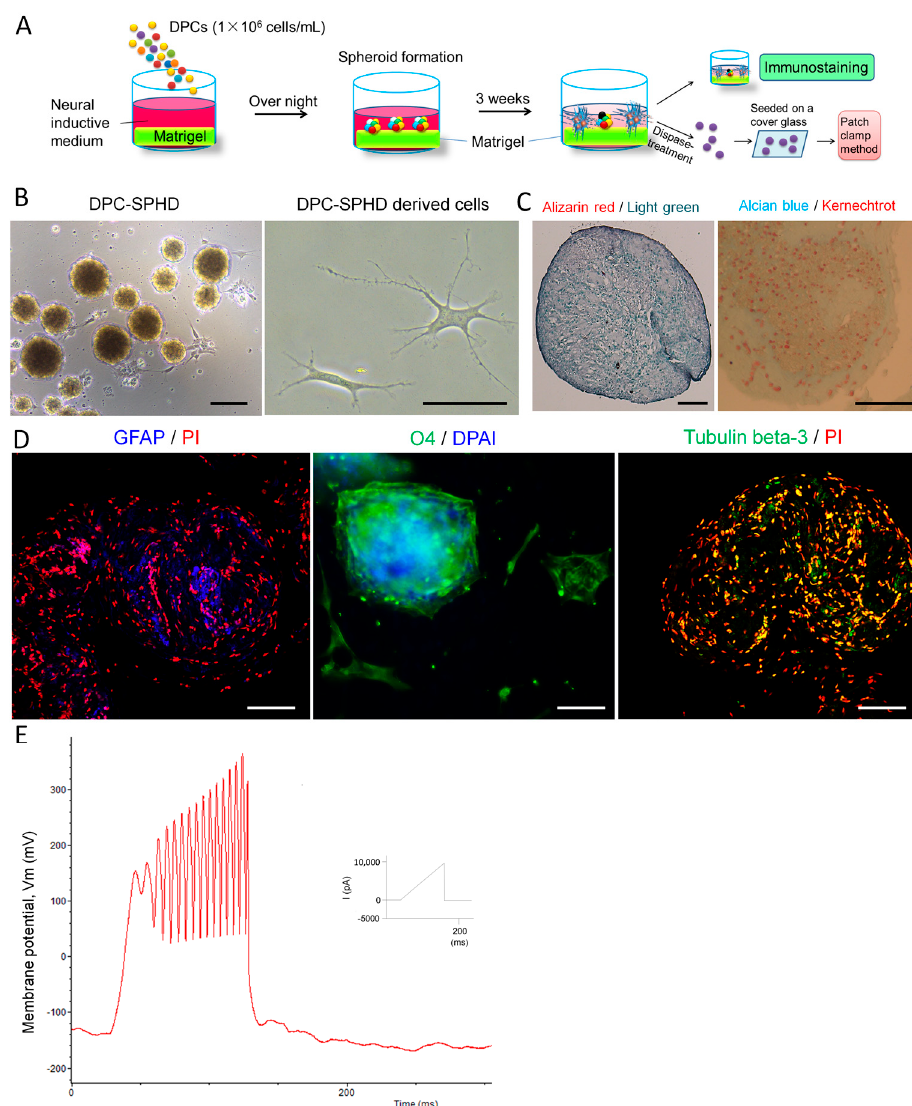
Figure 3. Expression of neural markers for differentiation and electrophysiological properties in DPC-formed spheroids on matrigel. DPCs were seeded on matrigel in neural inductive medium overnight. The cells spontaneously formed spheroids in 96-well culture plates and were further cultivated for 3 weeks. ( A ) Experimental setup; ( B ) The spheroids in culture for 3 days. Scale bar = 50 µ m; ( C ) Three weeks after neuronal induction, the spheroids were stained with alizarin red (nuclei were stained with light green) and alcian blue (nuclei were stained with kernechtrot). The spheroids were not stained by both alizarin red and alcian blue. Scale bar = 10 µ m; ( D ) Expression of neural markers for differentiation in the spheroids after 3 weeks cultivation (immunofluorescence staining). Images were taken by LSM. The spheroids expressed the glia cell marker, GFAP, oligodendrocyte, O4, and the neuron marker, tubulin β -3. Nuclei were stained with propidium iodide (PI) or DAPI. Scale bar = 25 µ m. DPC-SPHD, DPC-formed spheroids; ( E ) Electrophysiological characteristics of DPC-formed spheroids. Patch-clamp recordings of spheroid-derived cells. After being cultivated in neural inductive media for 3 weeks, spheroids were decomposed into single cells by dispase-treatment. The cells were seeded on a cover glass overnight to adhere to the glass surface. Action potential properties were analyzed by whole-cell patch-clamp recordings. Membrane potential oscillations were generated by ramp protocol using the current clamp mode with 10 nA maximal amplitude in spheroid-derived cells.